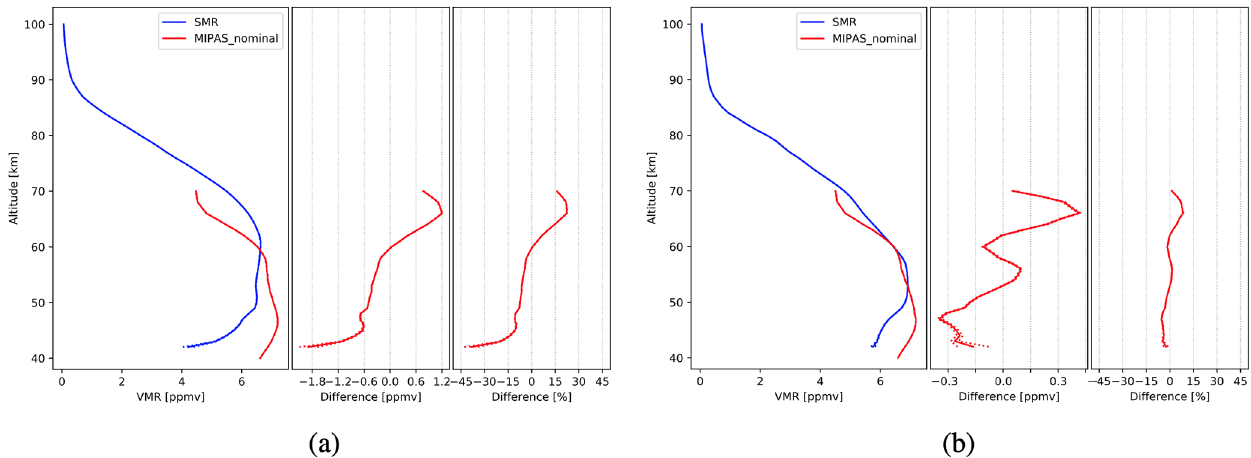
Figure 7. Comparison of SMR H 2 O profiles, from FM13 (a) and FM19 (b) , with those from MIPAS nominal mode retrievals. The data plotted are global averages over the time periods indicated in Table 2. Figure characteristics are the same as in Fig. 6.